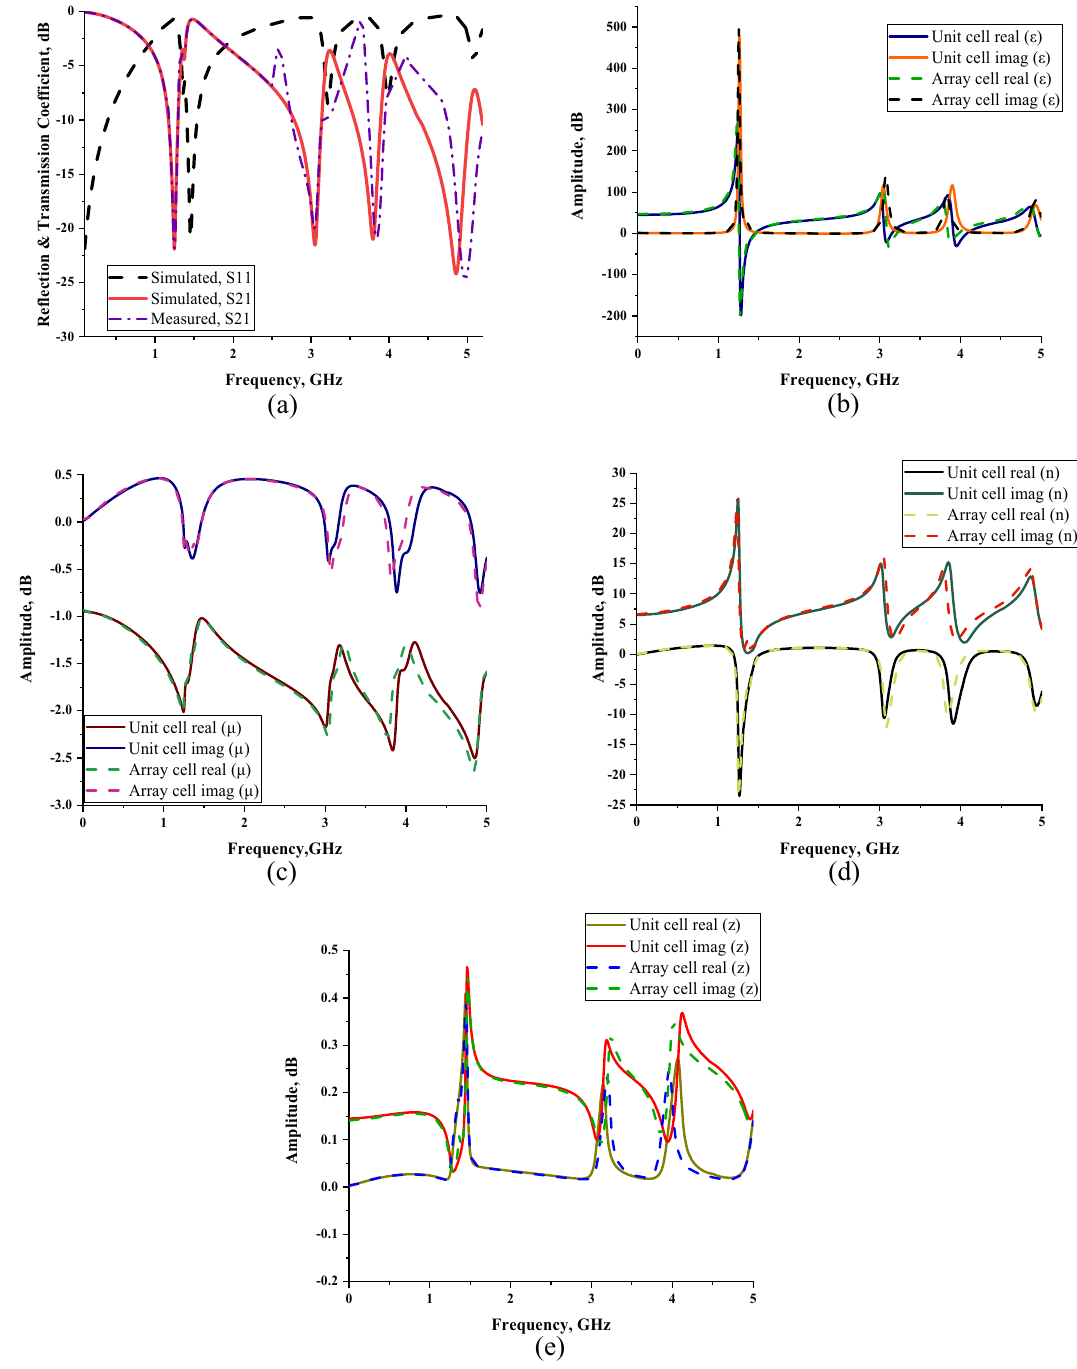
Figure 3. Scattering parameter of the proposed SS metamaterial for array cell: ( a ) numerically simulated (S11 and S21) and measured (S21); effective medium parameters for both unit and array cells ( b ) permittivity, ( c ) permeability, ( d ) refractive index, ( e ) impedance